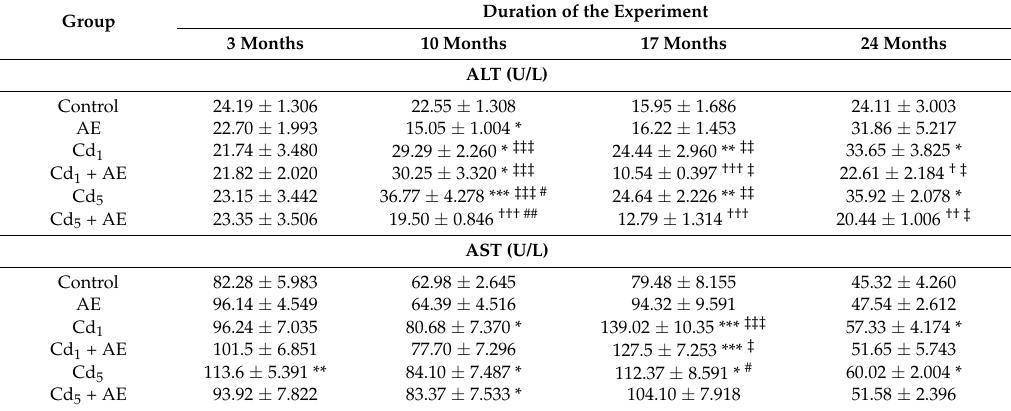
aminotransferase (ALT) and aspartate transaminase (AST) in the serum of rats exposed to cadmium (Cd) 1,2 . Duration of the Experiment Group 3 Months 10 Months 17 Months 24 Months ALT